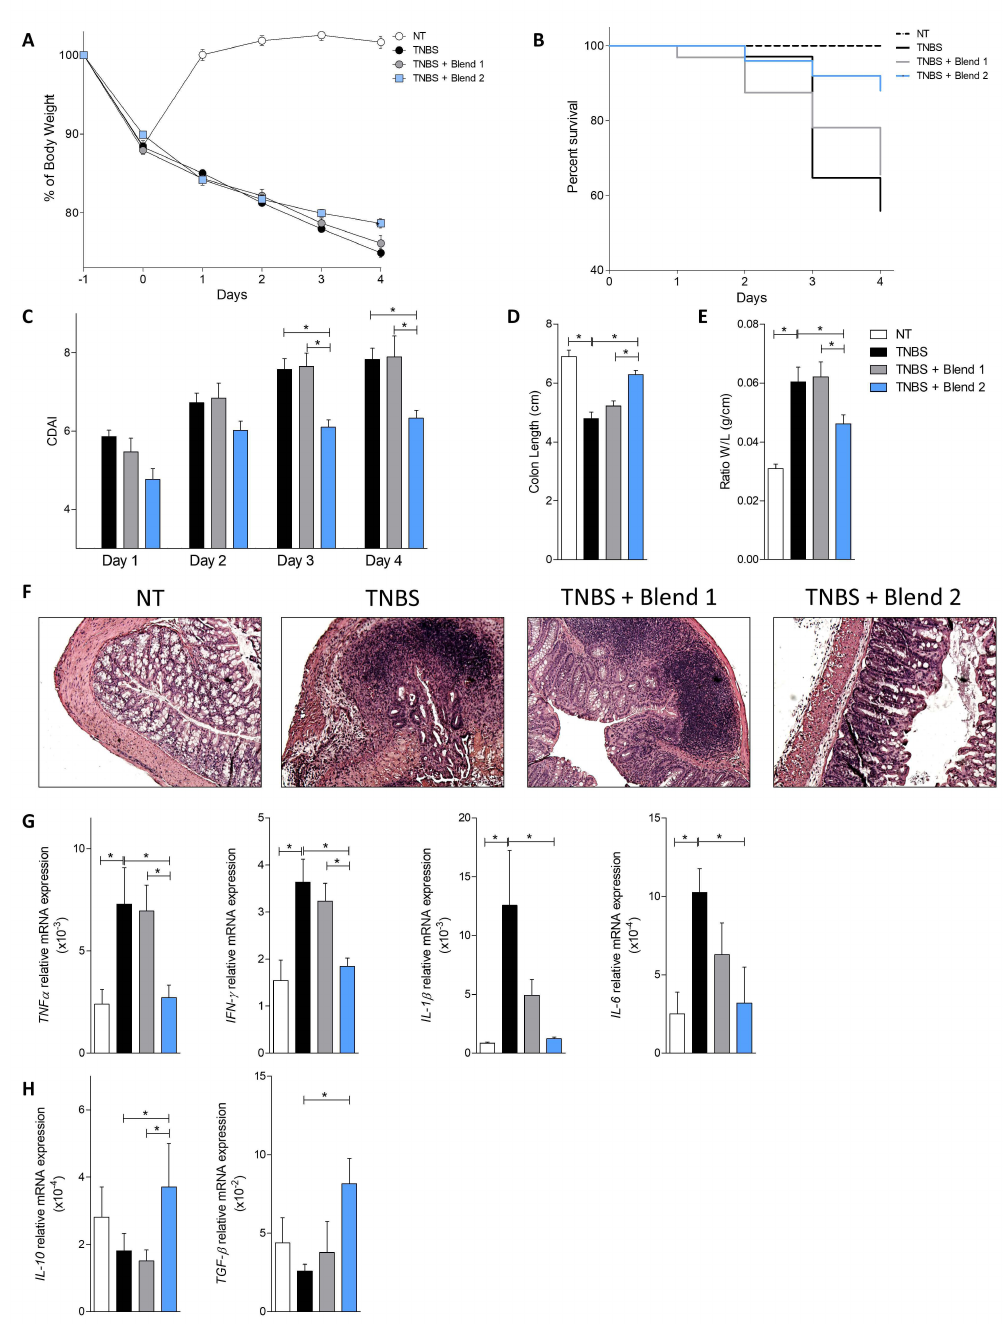
Figure 1. Effects of VSL#3 (Blend 1) and Vivomixx (Blend 2) on severity of colitis induced by 2,4,6-trinitrobenzenesulfonic acid (TNBS). Balb/c mice were injected intra-rectally as detailed in Materials and Methods with TNBS and then administered with vehicle or probiotics by gavage from day 0 to day 4. Blend 2 attenuated the development of the disease. Changes in body weight ( A ), survival ( B ), and the Colitis Disease Activity Index (CDAI) ( C ) of mice during the course of TNBS-induced colitis. Blend 2 reduced the intestinal inflammatory score: colon length ( D ) and ratio of colon weight/colon length ( E ). ( F ) H&E staining of colon sections from control mice, mice treated with TNBS, and mice treated with TNBS plus probiotics (original magnification 10 × ). Relative mRNA expression of Tnf- α , Ifn- γ , Il-1 β , and Il-6 ( G ) and Il-10 and Tgf- β ( H ) genes in colon was assayed by real-time PCR. Data are normalized to Gapdh mRNA. Results are the mean ± SEM of 5–7 mice per group. * p < 0.05. Abbreviations are: interleukin (Il)-1 β , -6, and -10; transforming growth factor (Tgf)- β ; tumor necrosis factor (Tnf)- α ; interferon (Ifn)- γ